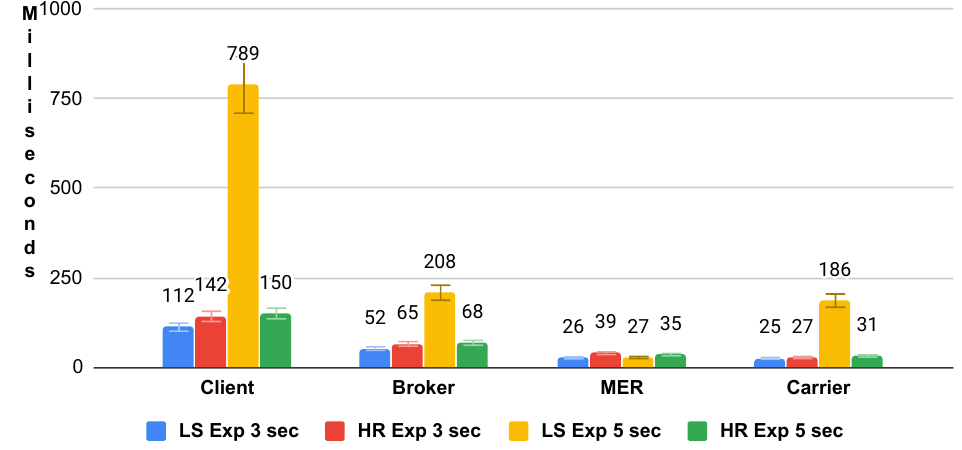
Figure 5. Average uniform exponential time.